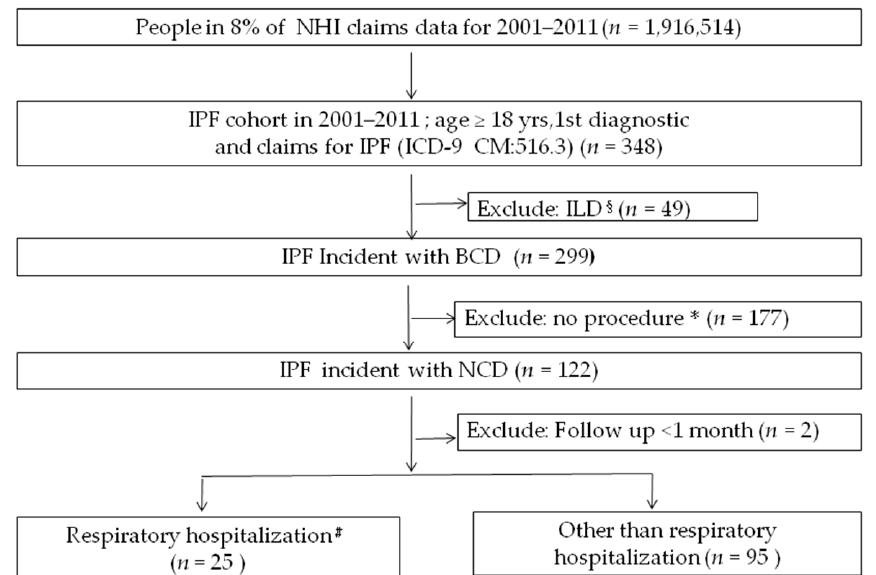
Figure 1. A flow chart to identify the cohort from Taiwanese NHIRD. § , ICD-9-CM for ILD; *, ICD-9- CM for lung biopsy or computed tomography of the thorax; # , ICD-9-CM for respiratory hospitalization. BCD, broad case definition; ILD, interstitial lung disease; IPF, idiopathic pulmonary fibrosis; NCD, narrow case definition; NHIRD, National Health Insurance Research Database.